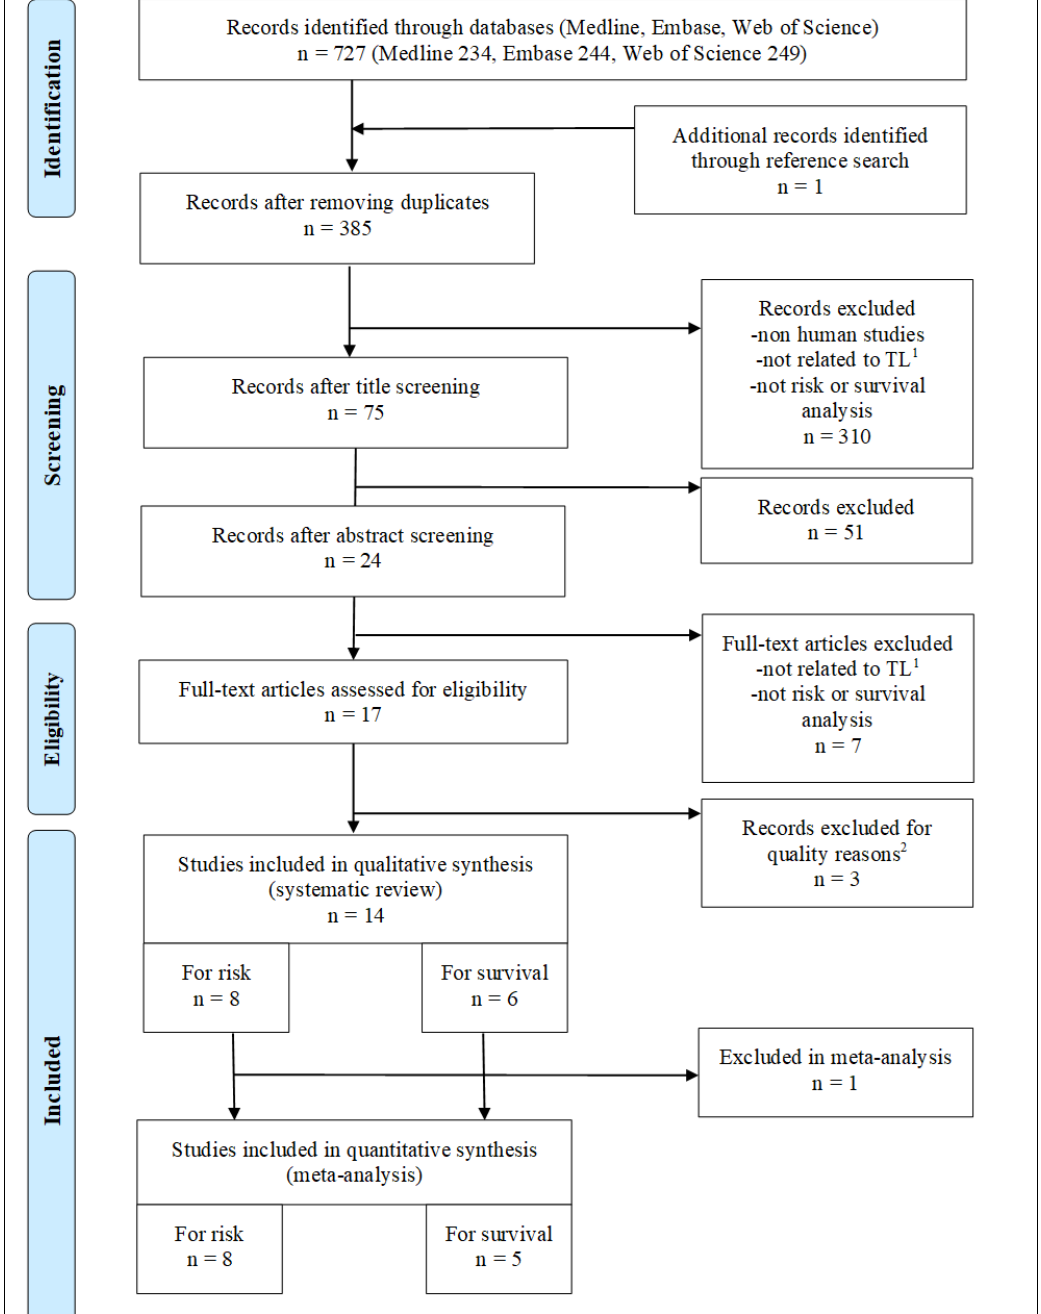
Figure 1. PRISMA flow diagram showing the selection and filtering steps for eligible studies for the association of telomere length in leukocytes or tumor tissue with colorectal cancer risk and